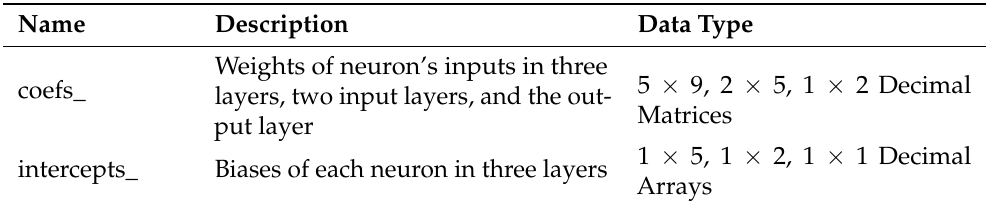
Table 3. MLP extracted